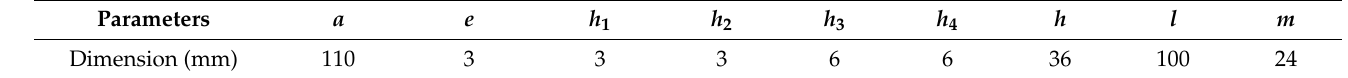
Table 2. Geometric parameters used in calculations (unit/mm).